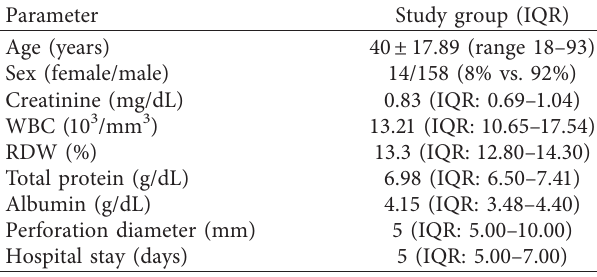
Table 1: Summary of the demographic and clinical characteristics of the study group.